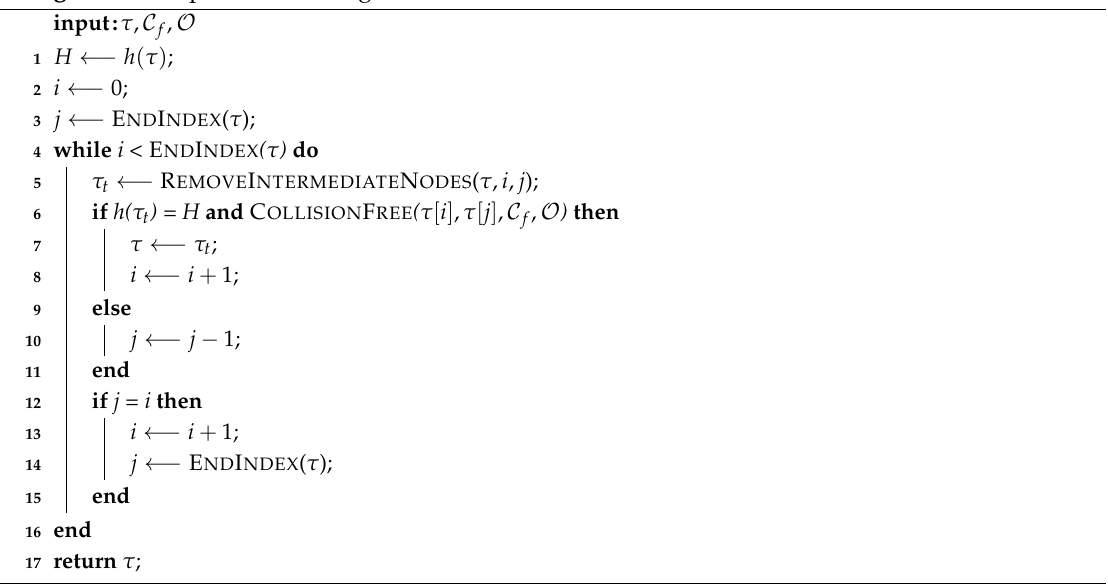
Algorithm 4 OptimizeShort algorithm.